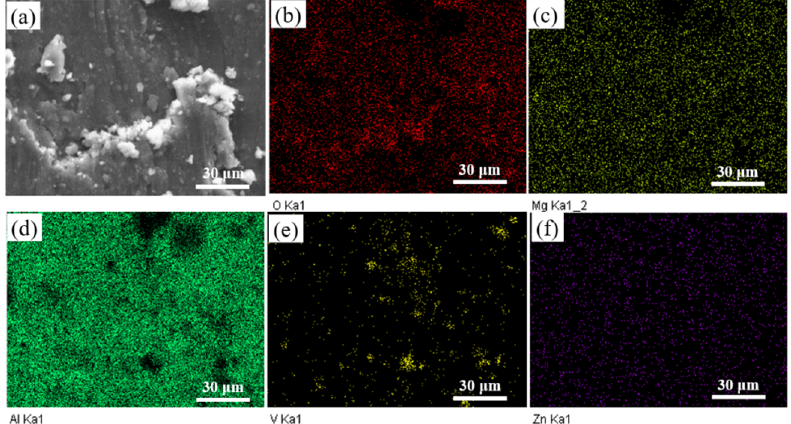
Figure 9. Elements distribution of 15 wt.% VN/7075 worn surface after wear test at 200 °C. ( a ) worn surface micromorphology; ( b ) O; ( c ) Mg; ( d ) Al; ( e ) V; ( f ) Zn.